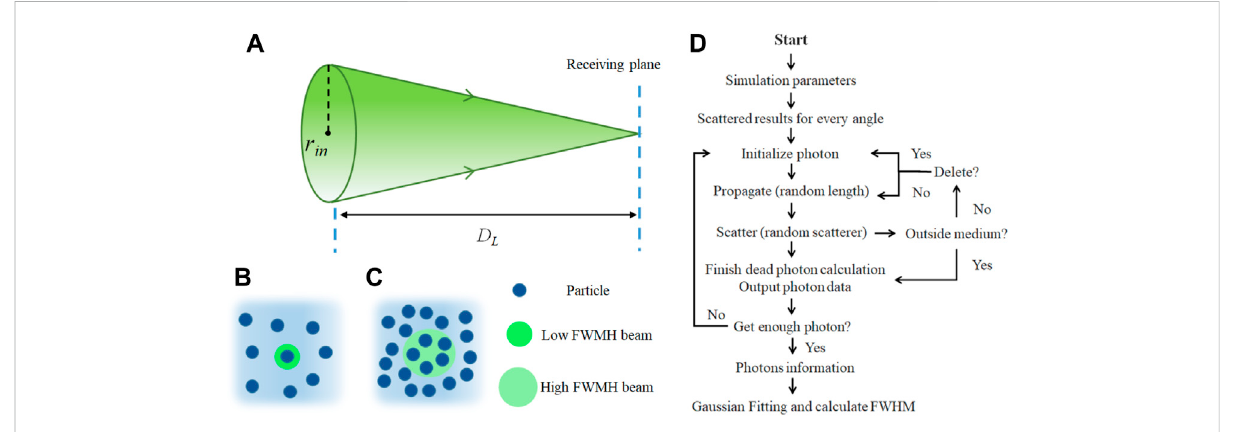
FIGURE 4 (A) Simulationmodeloftheconvergenceoflightbeam; (B) and (C) situationsofthelow-FWHMbeamandthehighFWHMbeam; (D) framework of the Monte Carlo